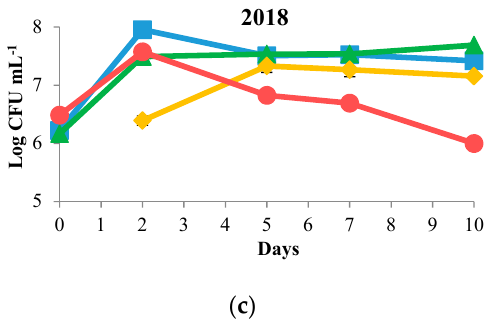
Figure 1. Growth kinetics of the pure and sequential fermentations in three consecutive years: 2016 ( a ), 2017 ( b ) and 2018 ( c ). Pure cultures of S. cerevisiae Lalvin ICV OKAY ® ( ) and S. cerevisiae DiSVA 708 ( ) in each vintage. Sequential fermentations of T. delbrueckii DiSVA 130 ( ) and S. cerevisiae DiSVA 708 (